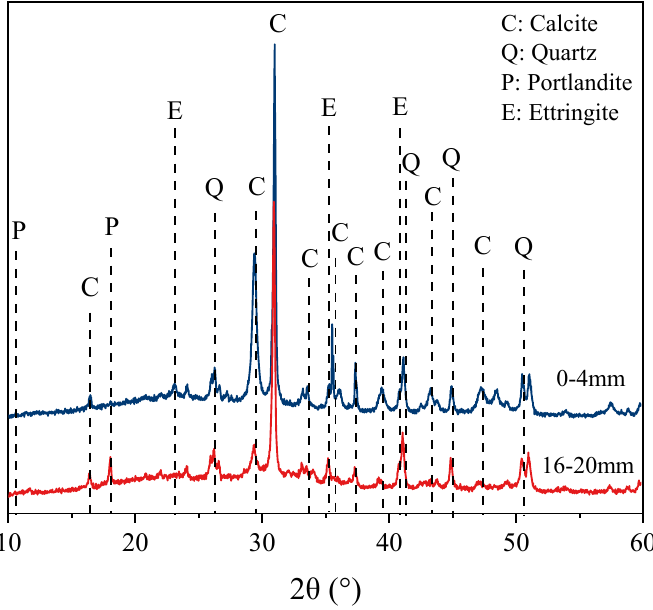
Figure 8. XRD results at different depths.